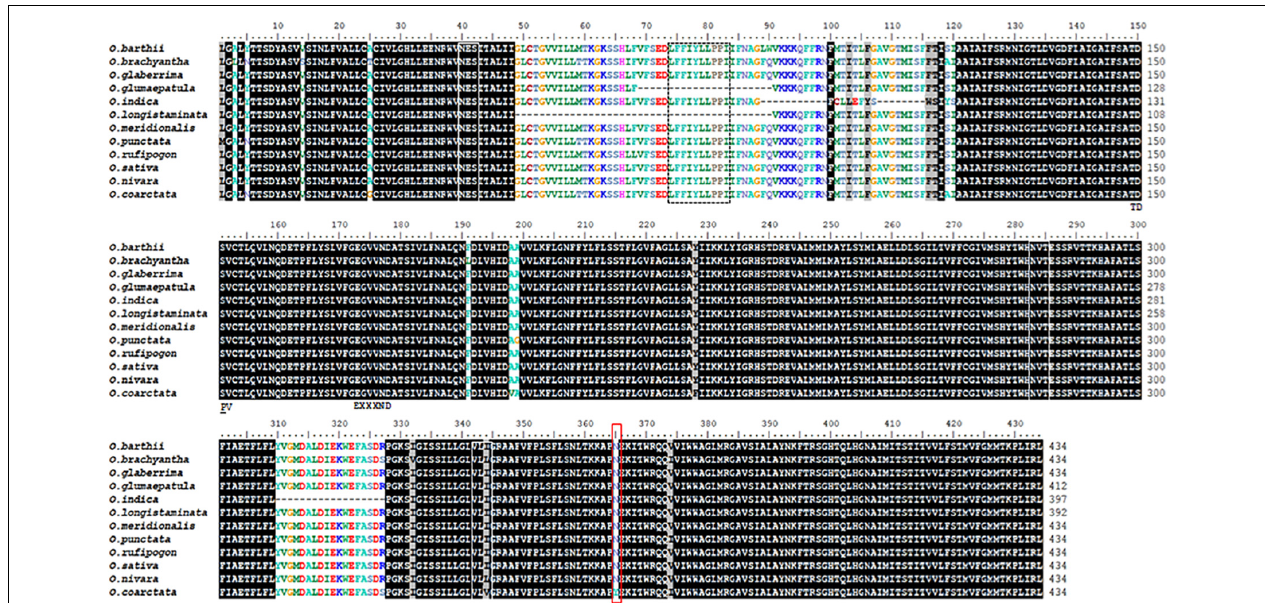
FIGURE 1 | Alignment of the Na + /H + exchanger domain found in NHX1 protein sequences ( Oryza species). The Na + /H + exchanger domain length is approximately 443-446 amino acid residues ( O. longistaminata and O. glumaepatula are exceptions). The Na + /H + inhibitory amiloride binding domain “LFFIYLLPPI” is boxed (dotted line). Putative glycosylation sites are conserved and indicated by white boxes (“NES,” “NVT,” and “VLI/V/L”). Motifs implicated in antiporter function: “A 1 T 2 D 3 S 4 ” (marked TDPV), “E 5 --- N 6 D 7 ” (marked EXXND), serine and arginine (R 8 ) residues (marked *) are also absolutely conserved across Oryza species. These motifs and residues occur on different transmembrane helices that form part of the protein core containing the substrate binding site (Masrati et al., 2018). The amino acid residues boxed in red are conserved across Oryza species except in O. coarctata